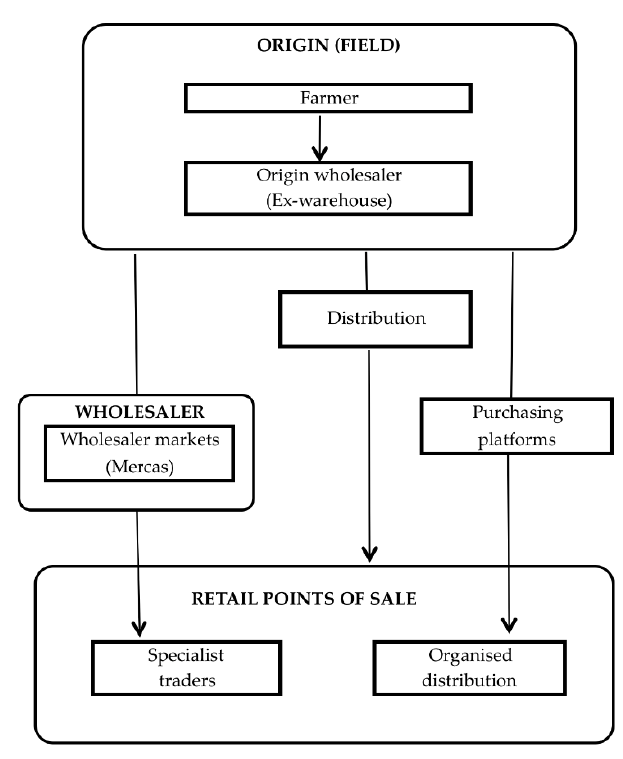
Figure 1. Citrus fruit value chain.